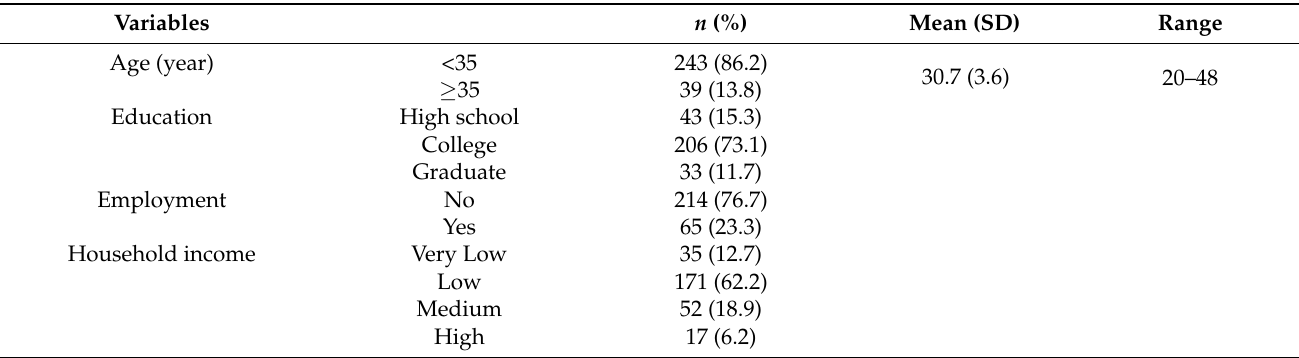
Table 1. Participant characteristics ( n =